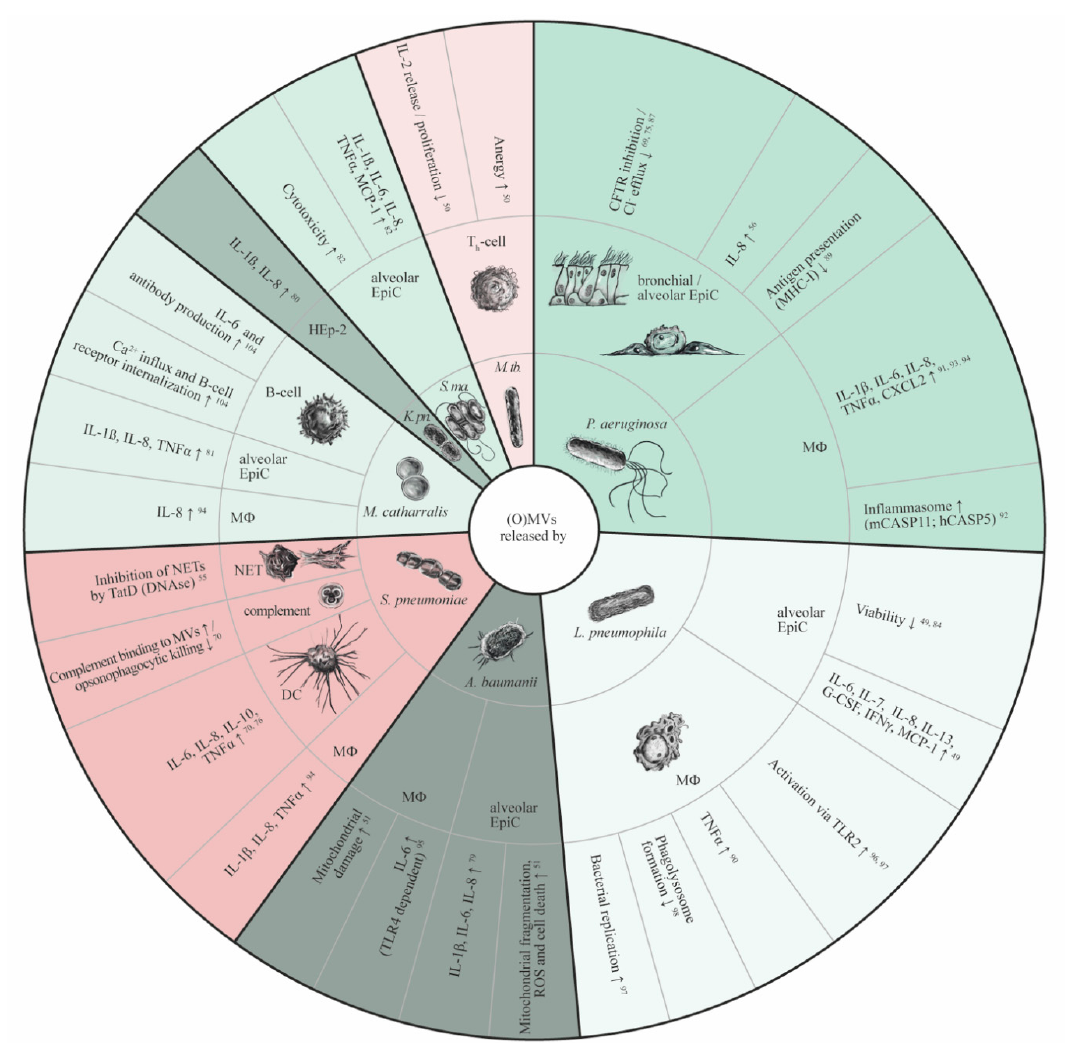
Figure 1. Functional properties of (O)MVs in pneumonia. Inner ring: (O)MV-releasing bacterial species; middle ring: (O)MV target cells; outer ring: (O)MV-mediated effects on target cells. Red areas: Gram-positive bacteria; green areas: Gram-negative bacteria. CFTR, cystic fibrosis transductance regulator; DC, dendritic cell; EpiC, epithelial cell; G-CSF, granulocyte colony-stimulating factor; hCASP5, human caspase-5; mCASP11, murine caspase-11; IFN γ , interferon- γ ; IL, interleukin; K. pn., Klebsiella pneumoniae ; M. tb, Mycobacterium tuberculosis ; MCP-1, monocyte chemoattractant protein-1; MHC-I, major histocompatibility complex-I; ΜΦ , macrophage; NET, neutrophil extracellular trap; S. ma., Stenotrophomonas maltophilia ; TLR, toll-like receptor; TNF α , tumor necrosis factor α .